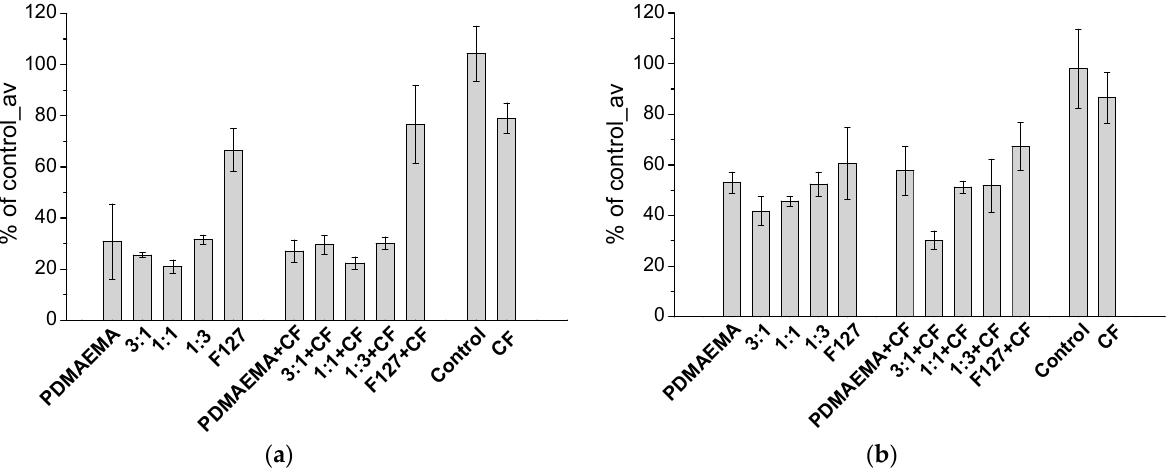
Figure 4. CF release profiles from SCPMs and MPMs based on PDMAEMA-b-PCL-b-PDMAEMA and Pluronic F127 triblock copolymers prepared at 10:1 polymer-to-drug mass ratio determined from HPLC. The release was performed at 37 ◦ C in phosphate buffer pH 7.4. Each data point represents the arithmetic mean ± SD of three separate experiments.